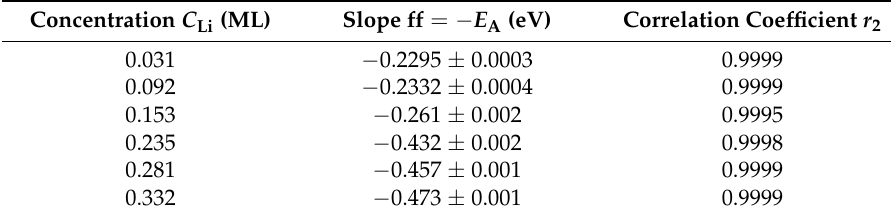
Figure 8. ( a ) The diffusion coefficient D Li as a function of temperature T ; ( b ) the logarithm of D Li as a function of 1/ ( k B T ) , and their fitting lines, for various Li + concentration C Li . Table 2. The slope α = − E A and correlation coefficient r 2 for the linear fitting line between ln( D Li ) and 1/ ( k B T ) , for different Li + concentration C Li Concentration C Li (ML) Slope (cid:2235) = −(cid:2161) (cid:1775) (eV) Correlation Coefficient r 2